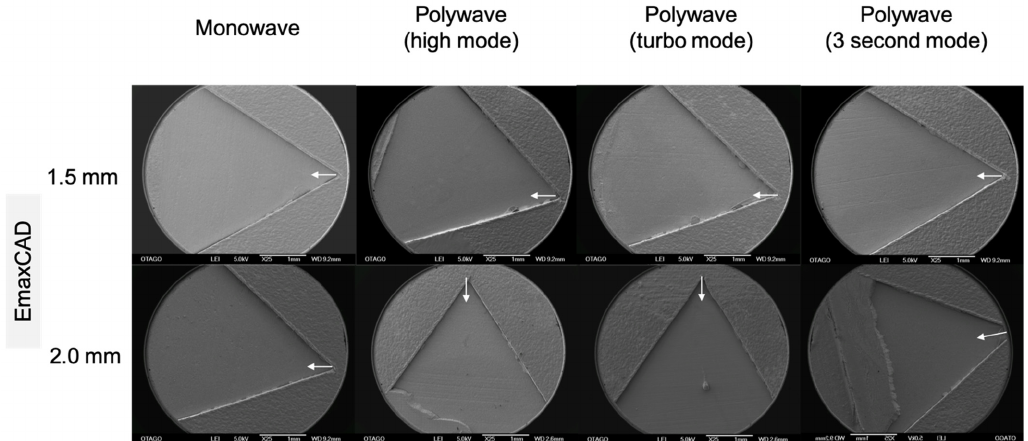
Figure 7. SEM images of bonded specimens between EmaxCAD and resin cement at 25 × magnifi- cation to show overall mode of failure. The arrow is positioned at the tip of the chevron notch and shows the direction of crack propogation.